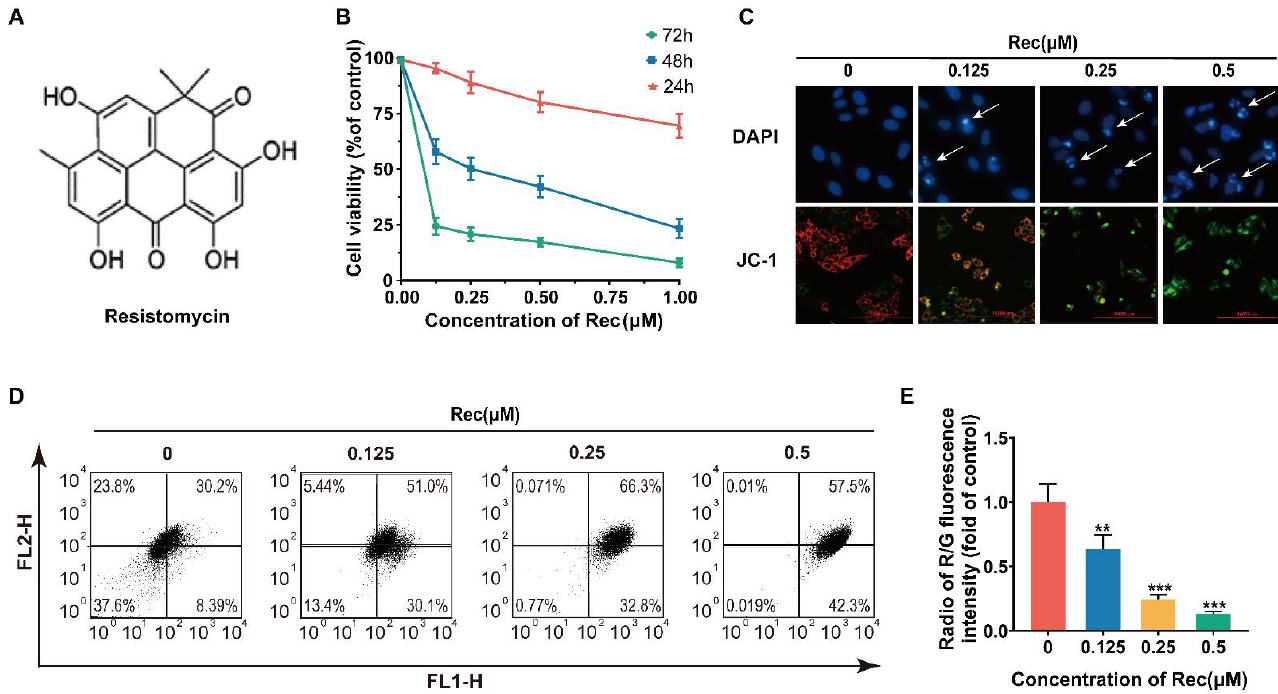
Figure 1. Resistomycin suppressed proliferation and decreased mitochondrial membrane potential (MMP) of HepG2 cells. ( A ) Structure of resistomycin. ( B ) Resistomycin exerted its anti-proliferative effect in a dose- and time-dependent manner when HepG2 cells were treated with resistomycin for 24 h, 48 h and 72 h and cell viability was determined using the MTT assay. ( C ) The results of DAPI and JC-1 staining after HepG2 cells were treated with different concentrations of resistomycin in 24 h. Arrow: apoptotic body in DAPI staining. JC-1: red fluorescence represents high mitochondrial membrane potential forming aggregates, green fluorescence represents low mitochondrial membrane potential forming monomers. Scale bar: 10000 μm (DAPI and JC-1). ( D , E ) Assay of flow cytometry showing the proportion of FL2-H to FL1-H in HepG2 cells treated with 0–0.5 μM resistomycin for 24 h. ** p < 0.01 and *** p < 0.001 versus 0 μM resistomycin..